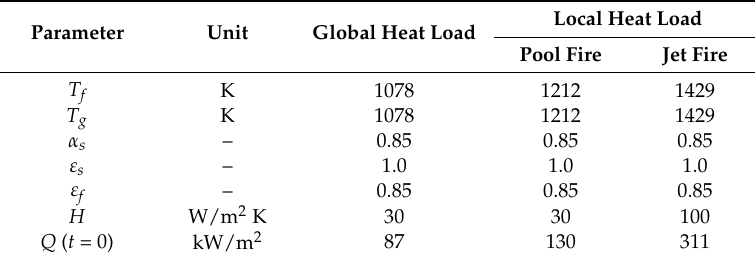
Table 2. Applied parameters in the fire heat flux